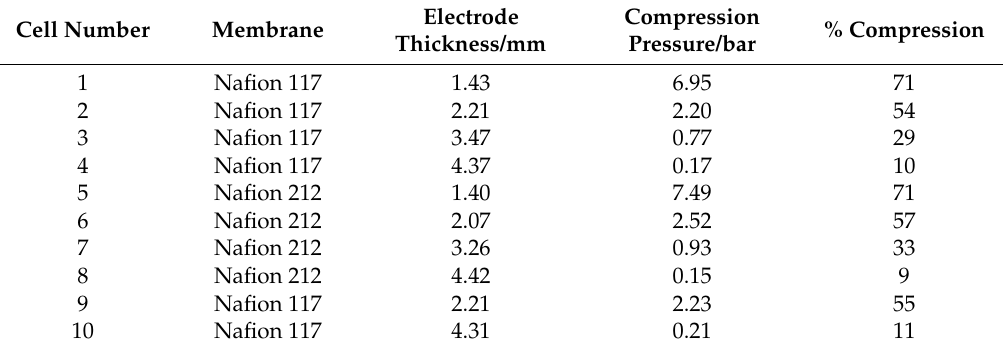
Table 1. Details of the cell builds used in vanadium redox flow batteries (VRFB) tests. The electrode material was GFD